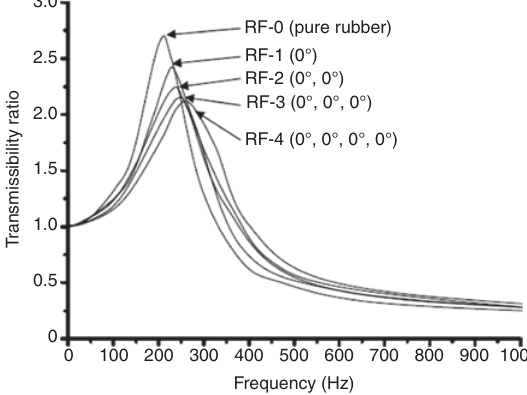
Figure 10: Dependence of transmissibility ratio of CR composites with different number of tire cord layers on frequency.